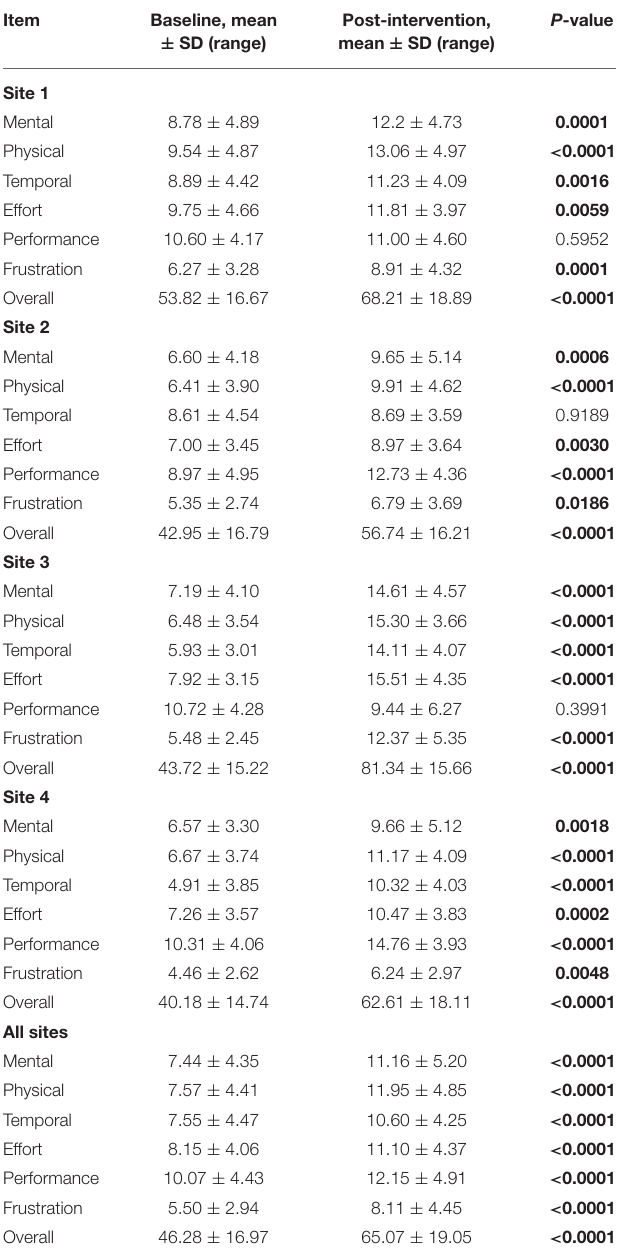
TABLE 6 | Workload among neonatal intensive care unit staff at baseline and post-intervention, as measured by